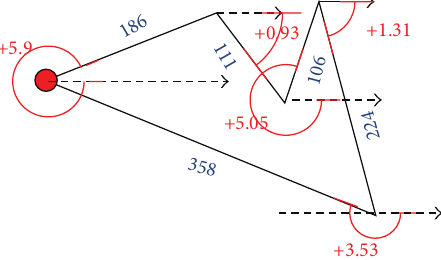
Figure 3: The absolute angles 𝜔 𝑖 of the polygon edges relative to the 𝑥